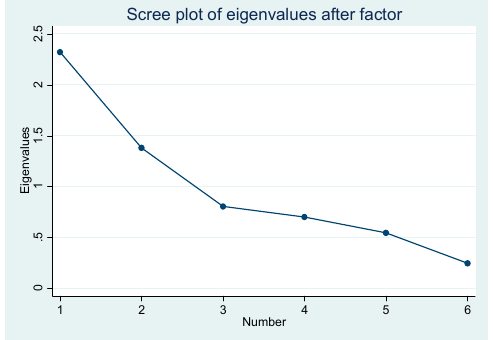
Figure 2. Scree plot of exploratory factor analysis.